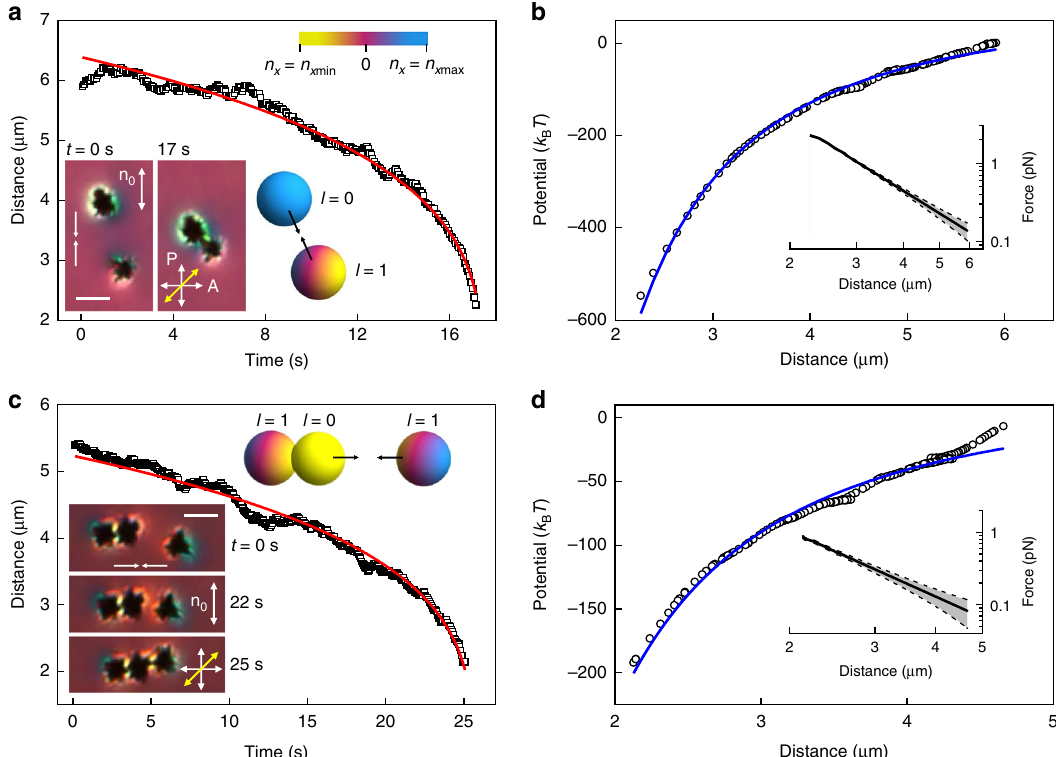
Fig. 4 Monopole-dipole elastic colloidal interaction between different meso fl owers. a , Separation distance versus time of attraction between monopole- like and dipole-like meso fl owers. Insets of micrographs show particle interaction probed with polarizing optical microscopy under crossed polarizer P and analyzer A, with an additional retardation plate (slow axis marked by yellow double arrow) inserted between them. Insets of color-coded spheres are visualization of n x values at spherical surfaces enveloping the particles. Direction of interaction is shown with pairs of arrows. b , Interaction potential versus distance corresponding to a , with inset showing distance dependence of force plotted using a log-log scale. c , Separation distance versus time of monopole- dipole attraction between an assembly of meso fl owes and an individual one. Insets show polarizing optical microscopy movie frames and visualization of n x values at spherical surfaces enveloping the particles. d , Interaction potential versus distance corresponding to c , with inset showing the distance dependence of force plotted using a log-log scale. The red curves in a , c are the best fi ts of the experimental data with the function r c ( t ) = ( r 0 n − n α t ) 1/ n where n = 4 for monopole-dipole interaction; the fi tting coef fi cients are r 0 = 6.4 μ m, α = 24 μ m 4 s − 1 in a and r 0 = 5.2 μ m, α = 7.3 μ m 4 s − 1 in c . The blue curves are the best fi ts of a power-law function ∝ − r c − 2 corresponding to the monopole-dipole interaction potential, from which the force is calculated. Gray bands with dashes in the inset represent estimated error of the force measurement. Scale bars are 3 μ